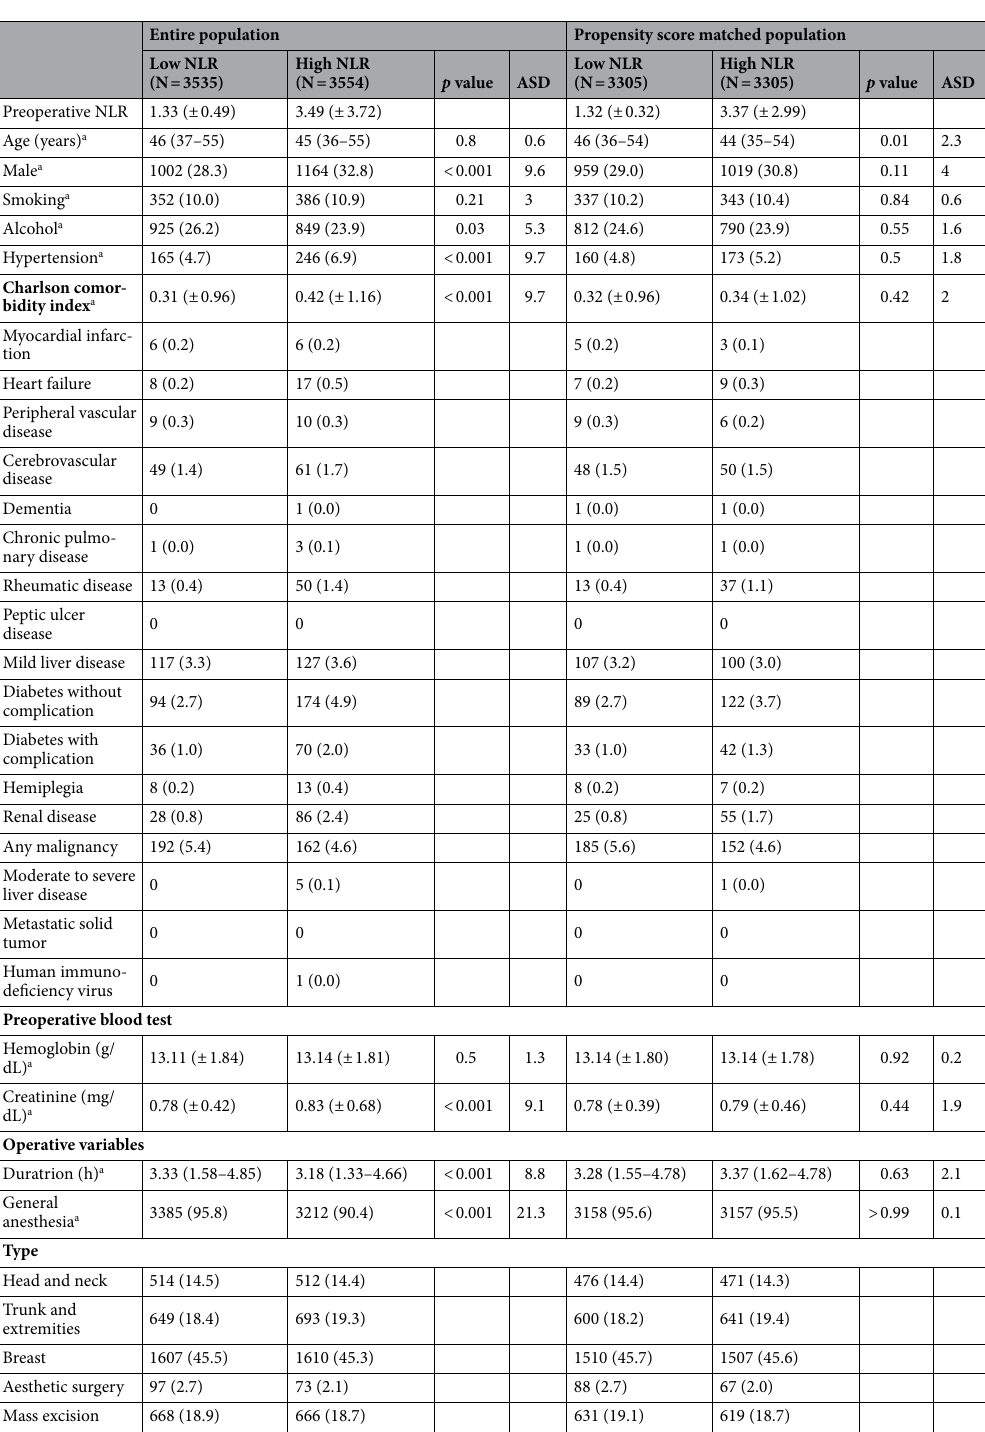
Table 1. Baseline characteristics according to the median value of preoperative NLR. Values are n (%), mean (± standardized difference), or median (interquartile range). ASD absolute standardized mean difference,